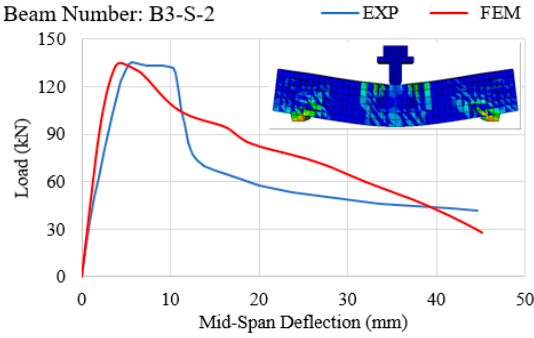
Figure 21. Load vs. mid-span deflection for B2-6B-S-1.